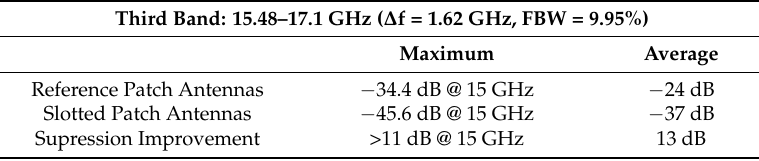
Table 3. Isolation in the second Ku-band.